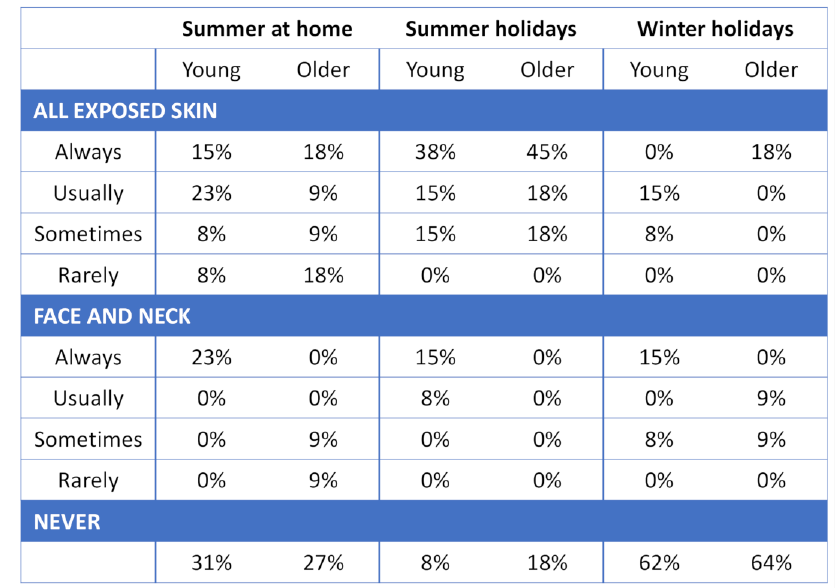
Figure 5. Responses to sunscreen use multiple choice question expressed as